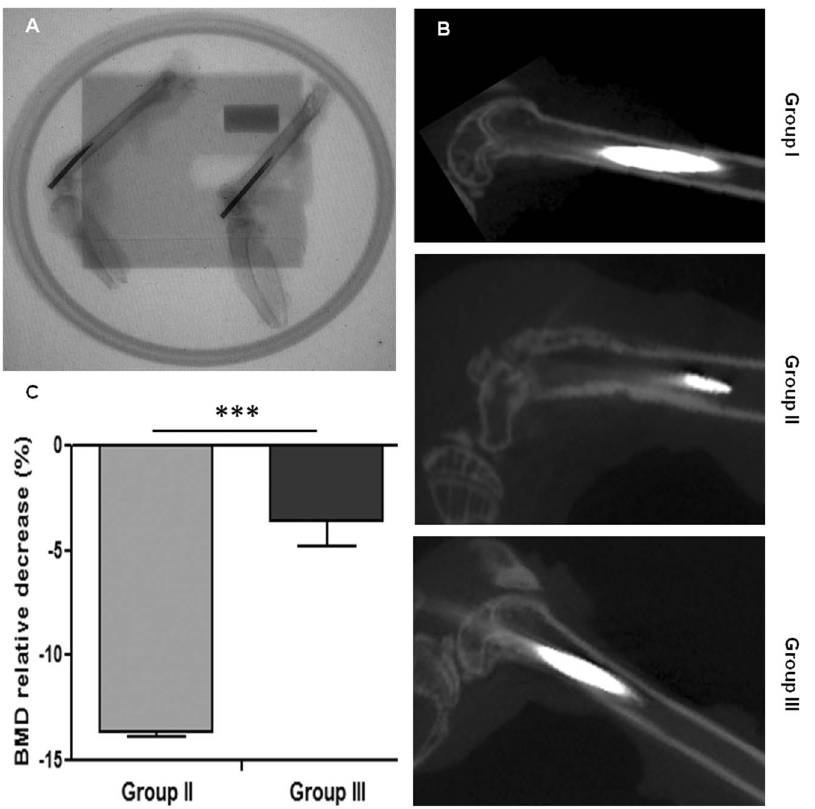
Fig. 2. Representative micro-CT images and bone mineral density (BMD). A) Representative fluoroscopic image attests the correct placement of the implant within the femoral canal and the phantom calibration placed in the field of view; B) Magnified representative micro-CT images of the femurs containing metallic implants in transversal views in all the experimental groups. The images of groups I and III show an intact cortical bone profile of the whole femur. The image of group II shows a diffuse cortical and endosteal bone loss as signs of osteomyelitis; C) The histogram shows a high statistically significant difference in the BMD relative decrease of group II versus group III (unpaired t-test, ***P , 0.0001;